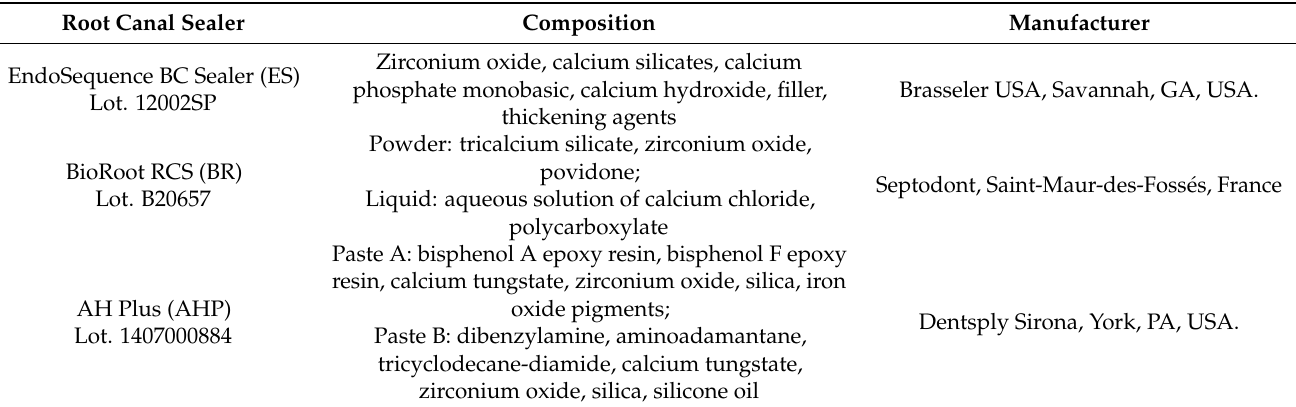
Table 1. Composition of the materials used in the